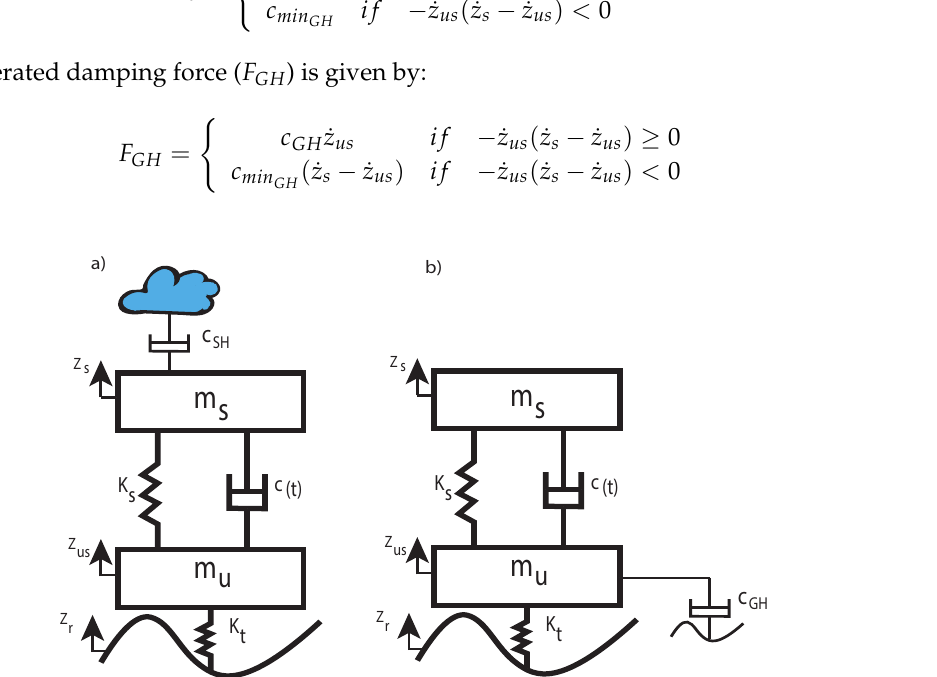
Figure 7. Heuristic controllers ( a ) Skyhook ( b )